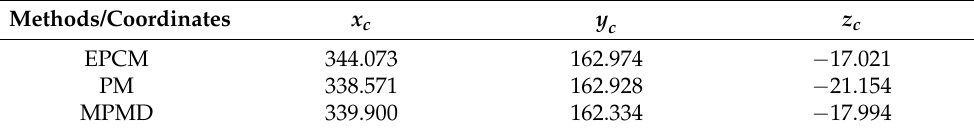
Table 2. Camera coordinates are obtained in three methods (EPCM, PM and MPMD). Unit: mm. Methods/Coordinates